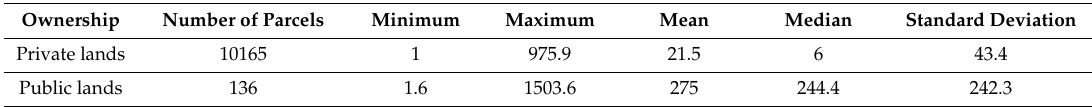
Table 1. Summary of parcel size of private and public lands larger than 1 acre in Hocking County, Ohio (unit: